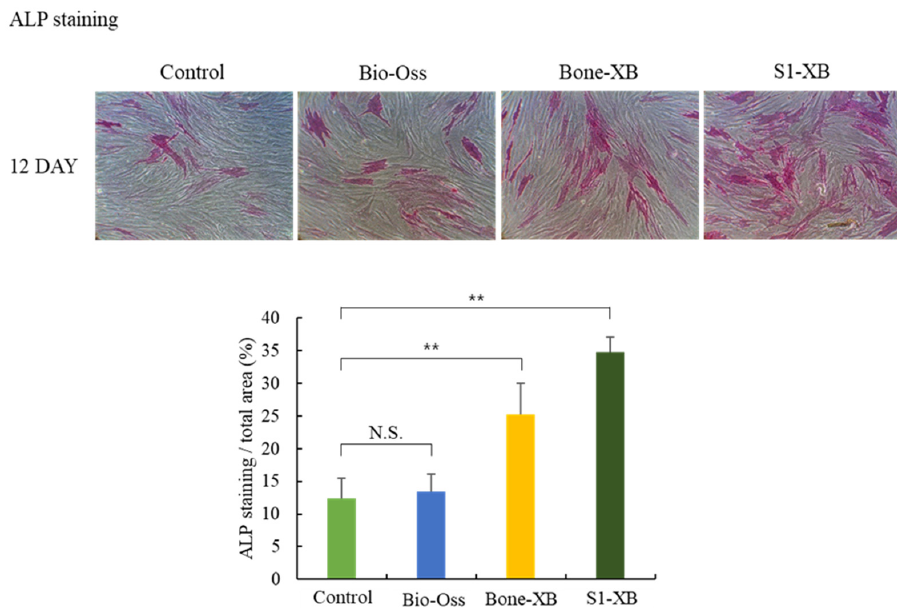
Figure 5. Cell osteogenic differentiation assay (** p < 0.01). The letter “**” indicates significant differences ( p < 0.05); N.S.—No significant.